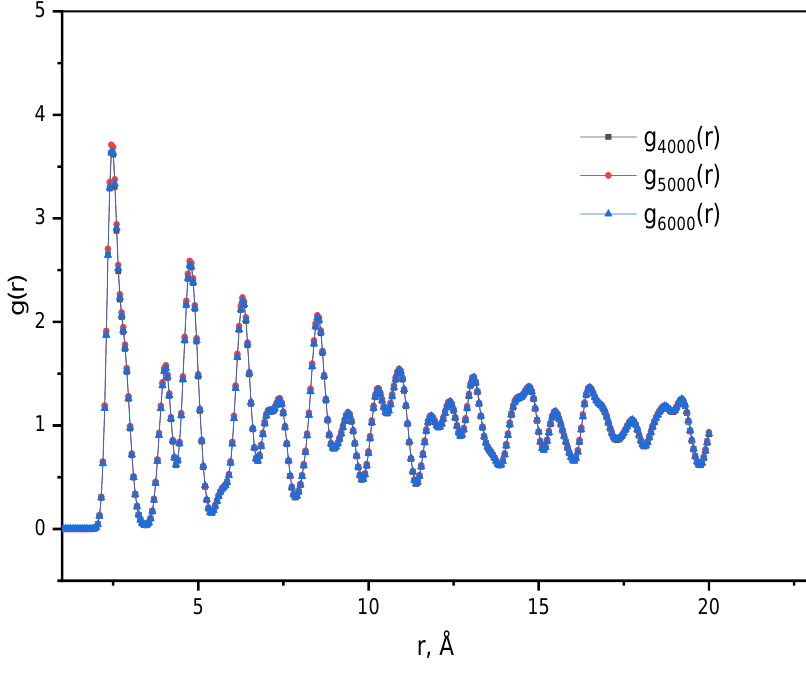
Figure 6. PRDF for 4000, 5000, 6000 atoms sample at 900 K